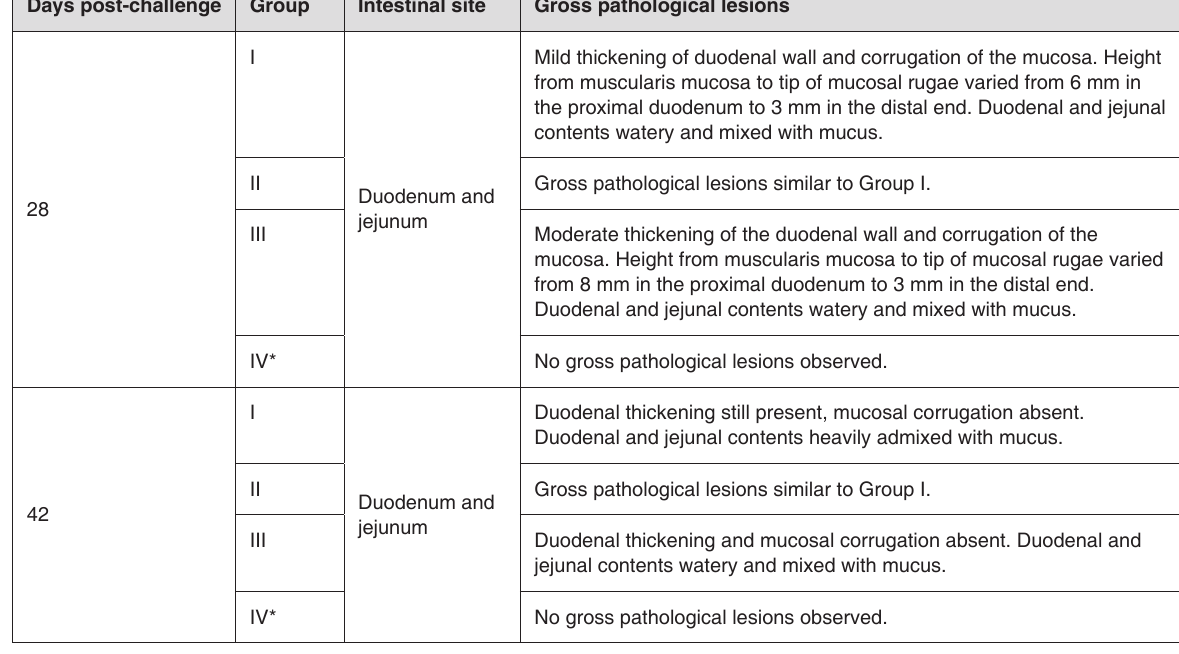
TABLE 3 Gross pathological lesions of the duodenum and jejunum of the different groups of cattle immunized and challenged with Calicophoron microbothrium Days post-challenge